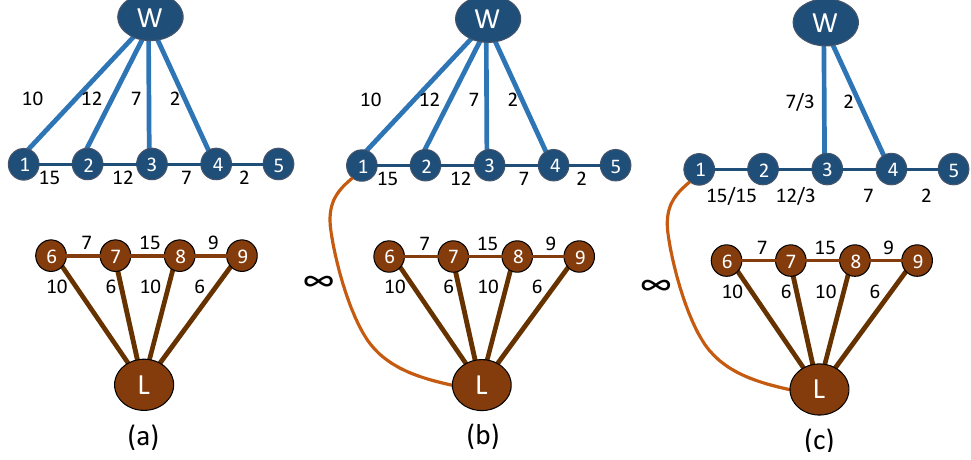
Figure 7. ( a ) is a two-dimensional representation of the final residual graph of Figure 6; ( b ) To measure the potential flow for the pixel 1, we assume that a t-link with infinite capacity is available between pixel 1 and the land terminal. Now the connection between two terminals is established, and the process of finding and augmenting new s-t paths starts again; ( c ) After augmenting all the new paths, the flow potential for pixel 1 assigned the label water ( C W augmented in the residual graph augmented in the previous step ( C W because pixel 1 does not connect to the other terminal in the residual